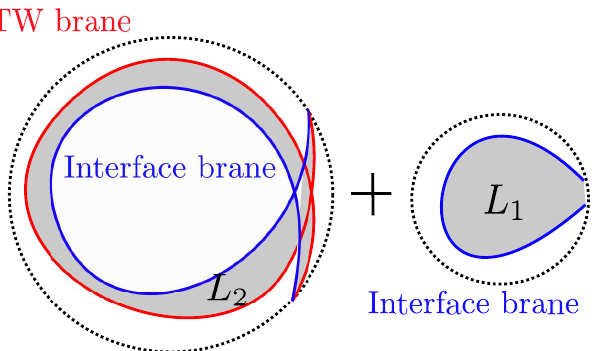
Figure 6 . Two Euclidean AdS soliton regions of a holographic interface solution. Here, z i is the angular direction and r is the radial direction, with i = 1 on the left and i = 2 on the right; planar i directions are suppressed. In this figure, region 1 is “multiply wound” in the z region 2 (which includes the horizon r = r ) is 2 H